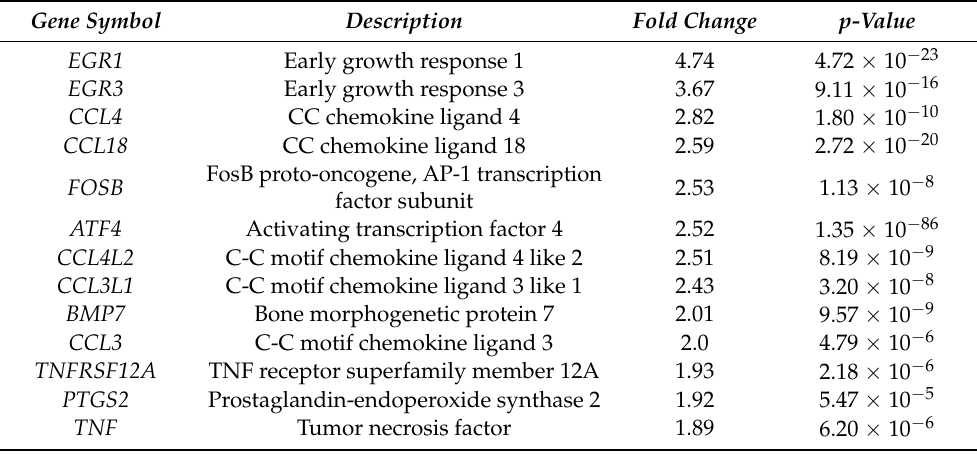
Table 2. List of differentially expressed genes ( p < 0.05 and fold-change 1.5) that belong to the cluster of cellular response